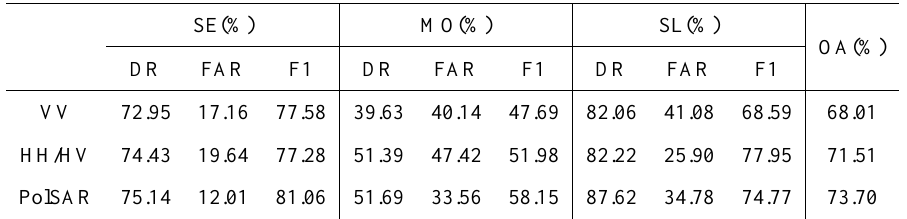
Table 2. The accuracies of building damage assessments for RADARSAT-2 data. The G 0 texture parameters of SAR data with different of HH/VV is smaller than HH or VV. Table 3 shows that the G 0 polarizations are shown in Table 3, which are based on the texture parameter of HV is not suitable for information sample table 2 in Figure. 2 (a). For single-polarization SAR data, extraction of collapsed buildings. For single-polarization SAR the AUC values of the G 0 texture parameters of the same- image, the introduced texture feature of HH and VV are similar, polarization SAR (HH or VV) are not much different but both and they are better than HV. For dual-polarization SAR image, larger than HV. In dual-polarization SAR data, the AUC values HH/VV, HH/HV and VV/VH have the similar results, which of the combination of co-polarization and cross-polarization are close to full-polarization SAR image. (HH/HV or VH/VV) are all greater than HH/VV, and the value